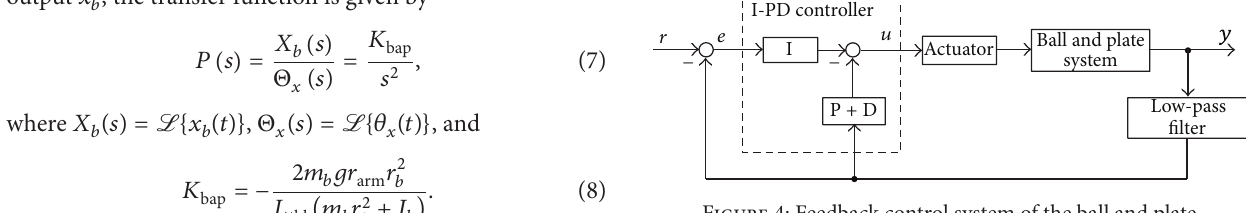
Figure 4: Feedback control system of the ball and